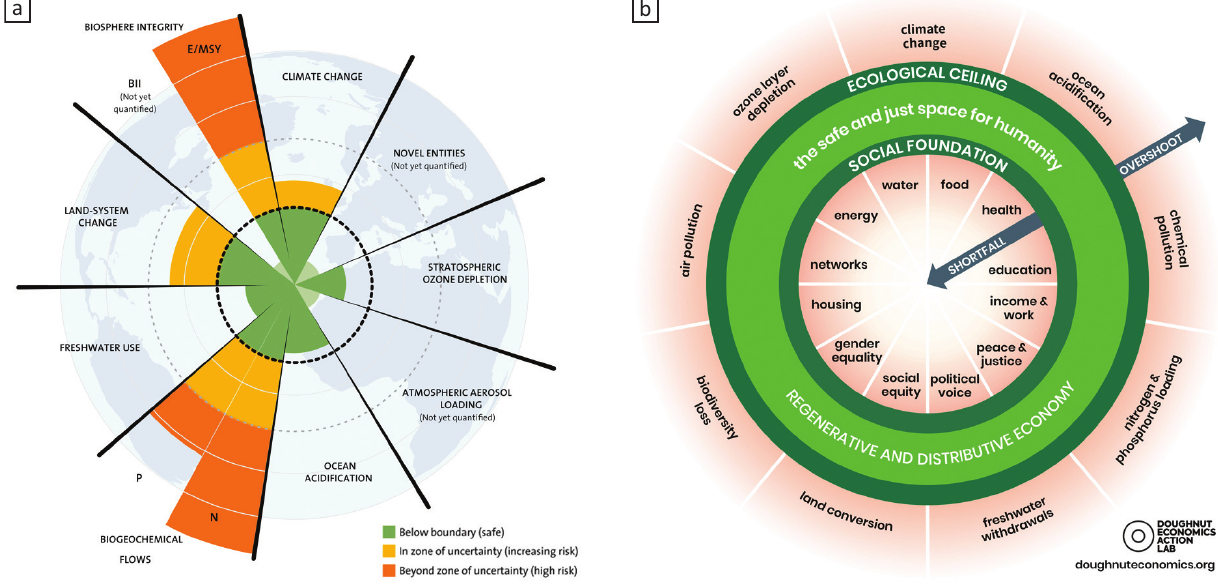
Figure 1. (a) PB framework, and (b) the “doughnut” of social and PB. Sources: (a) J. Lokrantz/Azote, based on Steffen et al. (2015); (b) Kate Raworth and Christian Guthier (CC‐BY‐SA 4.0; Raworth,